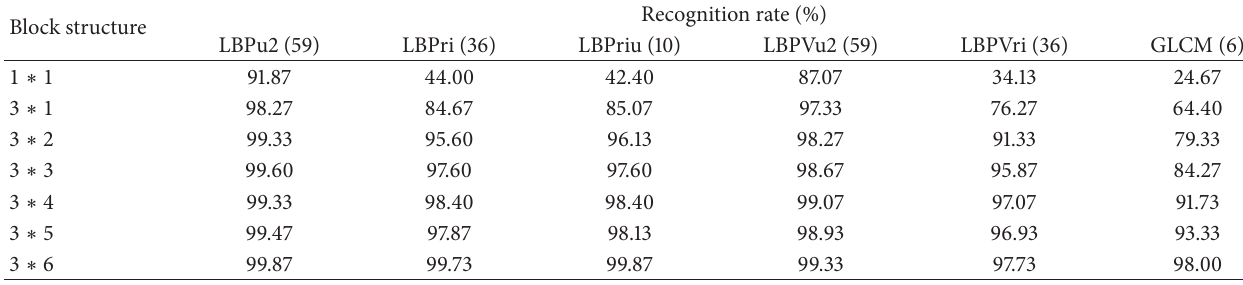
Table 1: Recognition results using different partitioning structures.